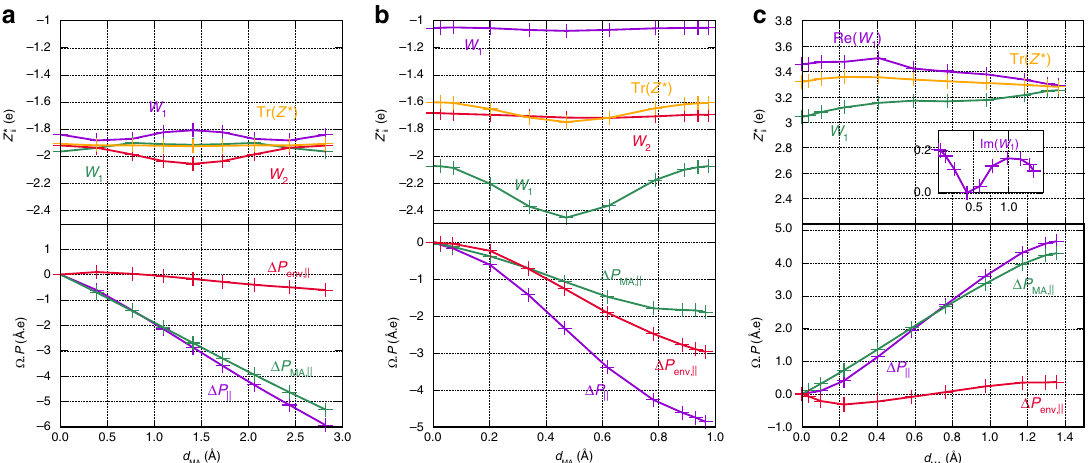
Fig. 3 First-principles Born effective charges and macroscopic polarization change along defect migration path. Top panels show the evolution of the eigenvalues and the trace (Tr( Z *)) of the BEC matrix Z (cid:4) αβ of the moving atom (MA) as function of its net displacement ( d MA ), for, respectively, V 2 þ ( a , the MA is an oxygen atom), I 2 (cid:3) ( b , the MA is an oxygen atom), and V 2 þ ( c , the MA is a silicon atom) in SiO 2 . The inset in c shows the imaginary part of O O eigenvalue W 1 (as the BEC is a real matrix but not symmetric, its diagonalization might lead to a real eigenvalue and two complex conjugate eigenvalues; see also ref. 38 ). Bottom panels display the evolution of the parallel projection of the total macroscopic polarization, Δ P ∥ , of the parallel projection of the MA contribution, Δ P MA, ∥ , and of the environment contribution Δ P env, ∥ , as a function of the MA net displacement, d MA . Table 1 Polarization change computed fully from fi rst- principles (FP) and from different levels of approximations for V 2 þ in MgO, and for I 2 (cid:2) and V 2 þ in SiO 2 . O O O